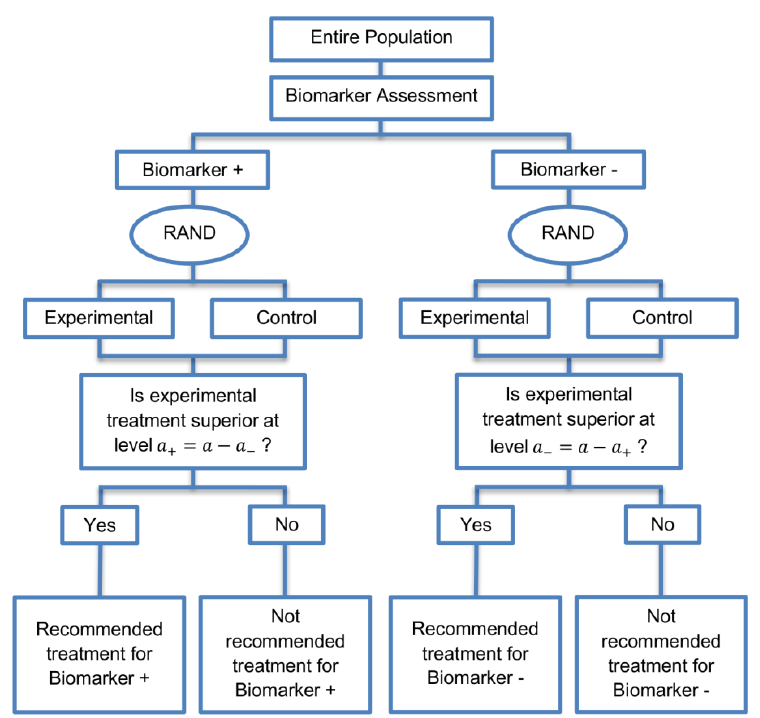
Figure 1. Parallel Subgroup-Specific design. “RAND” refers to randomization of patients. a refers to the overall significance level between the two biomarker subgroup tests such that a = a − + a +